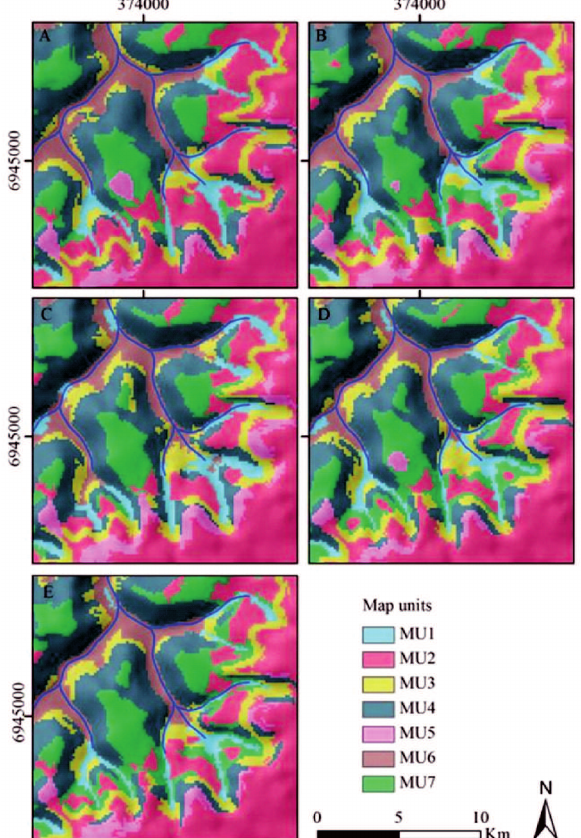
Figure 4. Extracts of the soil maps predicted from five sets of samples: (a) 5 %, (b) 10 %, (c) 15 %, (d) 20 %, (e) 25 %. Coordinate System SIRGAS2000 UTM zone